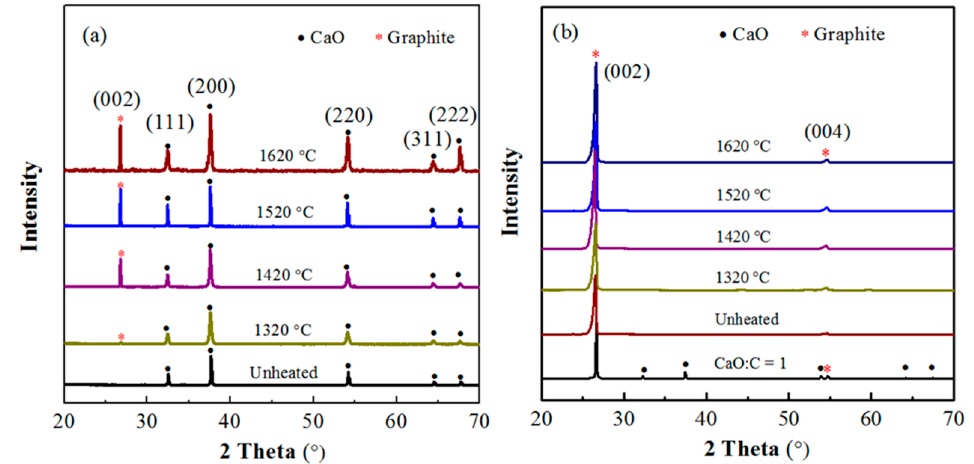
Figure 5. XRD pattern of CaO and graphite samples subjected to microwave treatment in a tem- perature range of 1320–1620 °C: ( a ) CaO; ( b ) graphite. 1320–1620 ◦ C: ( a ) CaO; ( b )